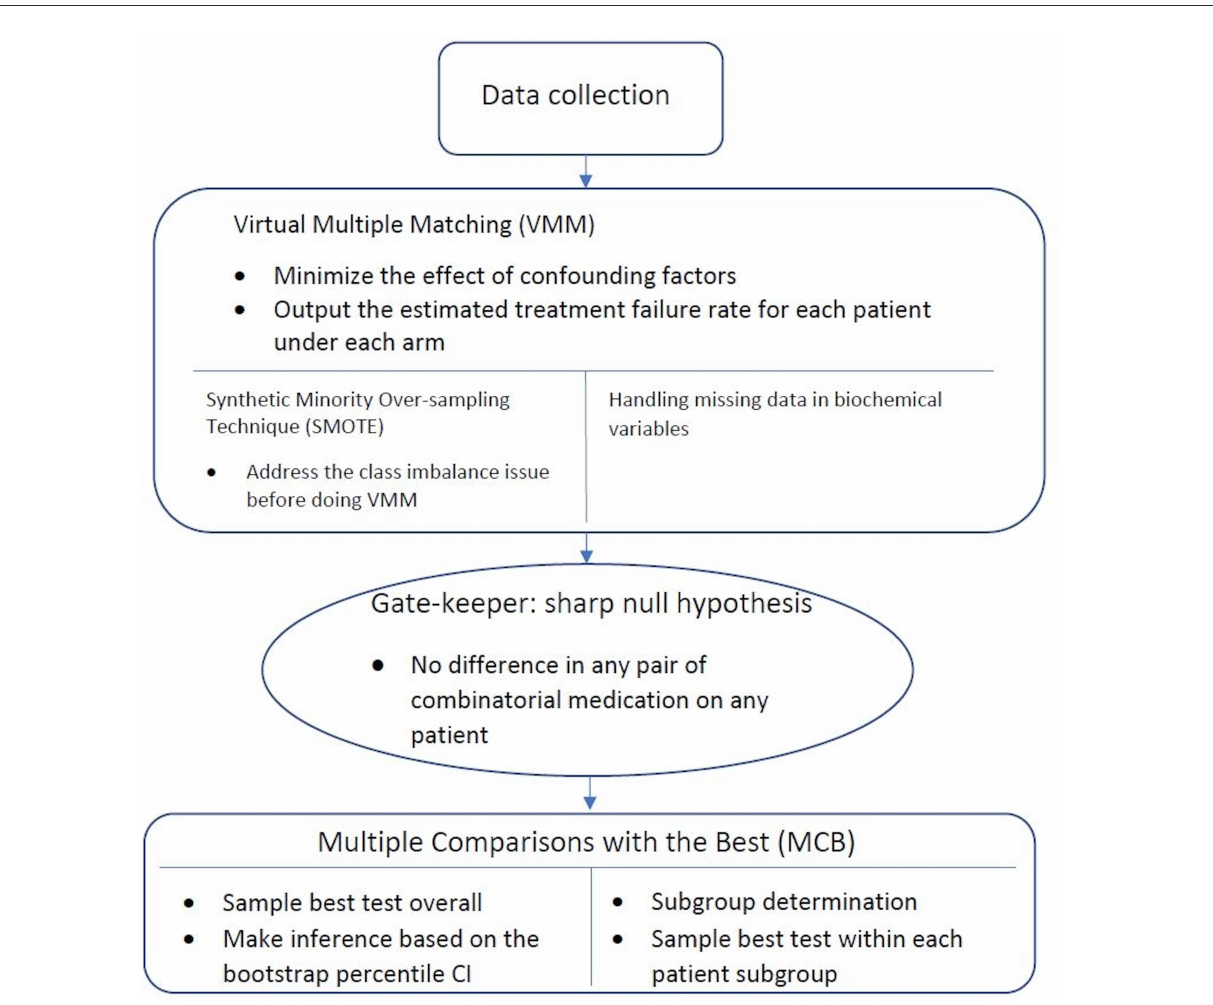
FIGURE1 Workflow of statistical analysis. After the data is collected, Virtual Multiple Matching (VMM) is first performed to minimize the effect of confounding factors. SMOTE is applied with the class imbalance, and missing indicator method is applied with missing values. Sharp null hypothesis is then conducted as the gate-keeper to test if there is an overall combinatorial treatment efficacy. Finally, Multiple Comparisons with the Best (MCB) is performed to select the best drug combination strategy within each patient subgroups, stratified in a data-driven